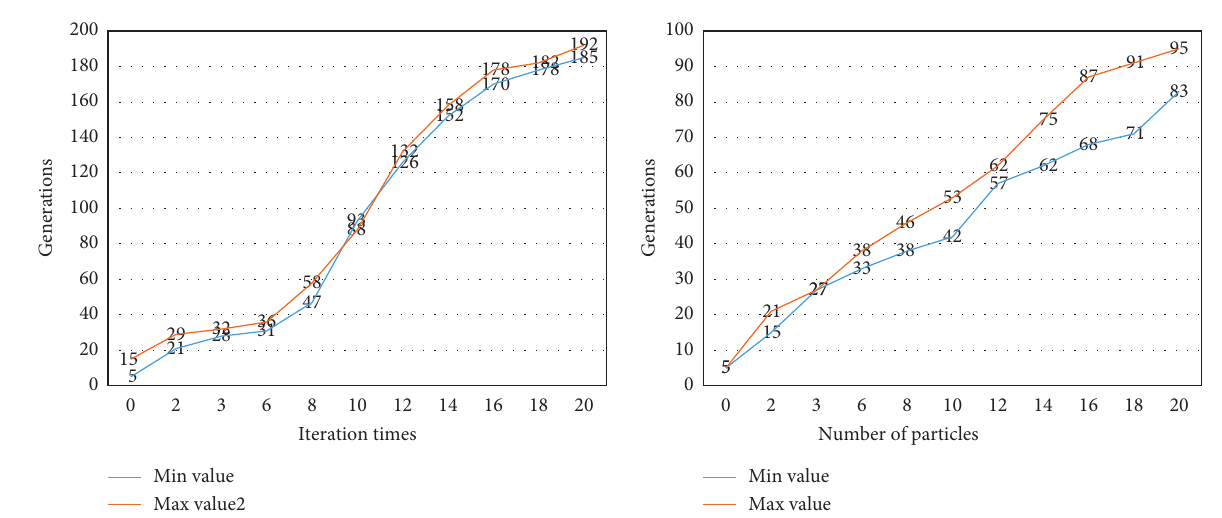
Figure 2: Flow chart of LTQPSO algorithm.